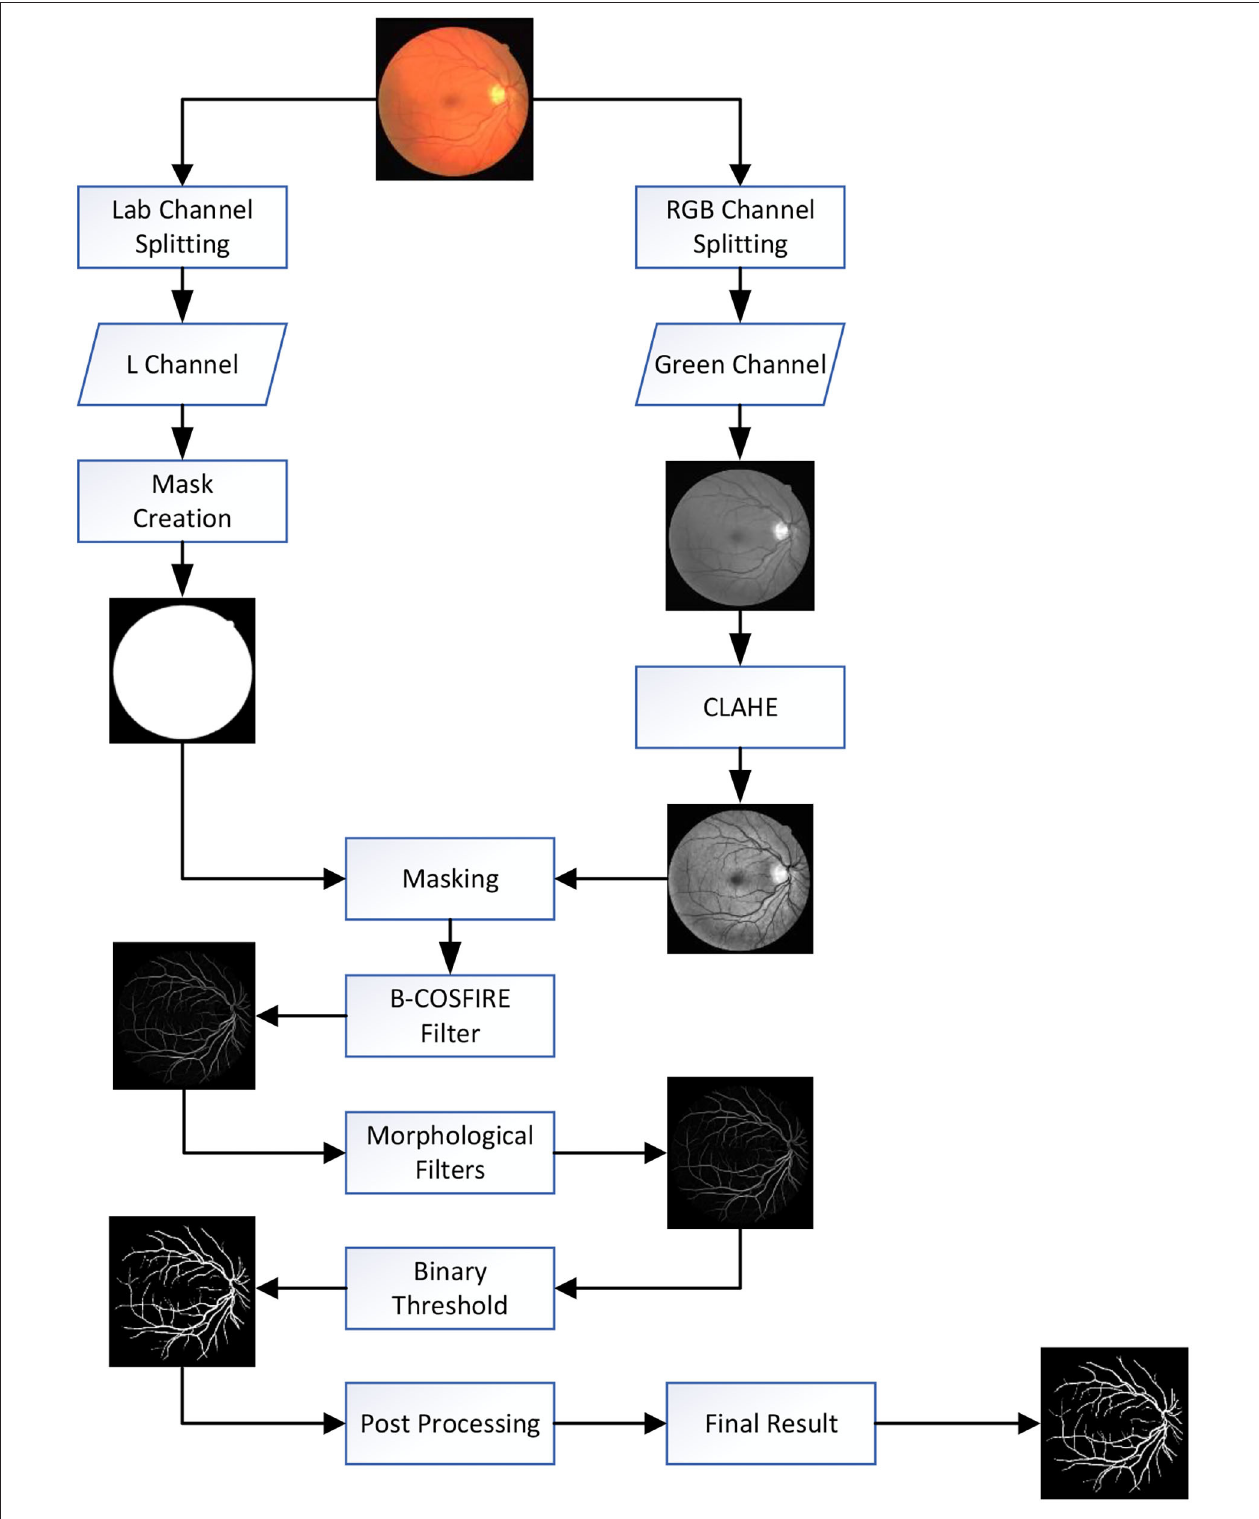
FIGURE 2 | Flowchart of proposed method: first, we using contrast limited adaptive histogram equalization (CLAHE) for contrast enhancement. Second, we threshold the luminance plane of the CIELab version of the original RGB image to produce a mask. Third, we apply the B-COSFIRE filter and morphological filter to detect blood vessels and remove noise. Fourth, the binary threshold was used for vessel segmentation. Finally, unconnected non-vessel pixels are eliminated by post-processing to obtain the final segmentation map.